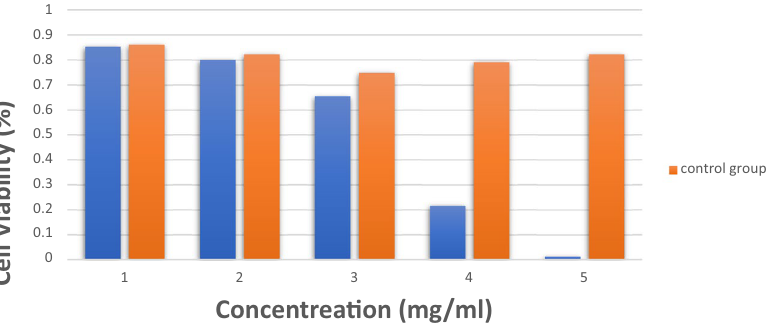
Figure 6. Cell proliferation test (MTT) for [(Fe 3 O 4 @EOP/CS/PLA/PU-Mo-Ge) PEGylated], and Control group (NPs without